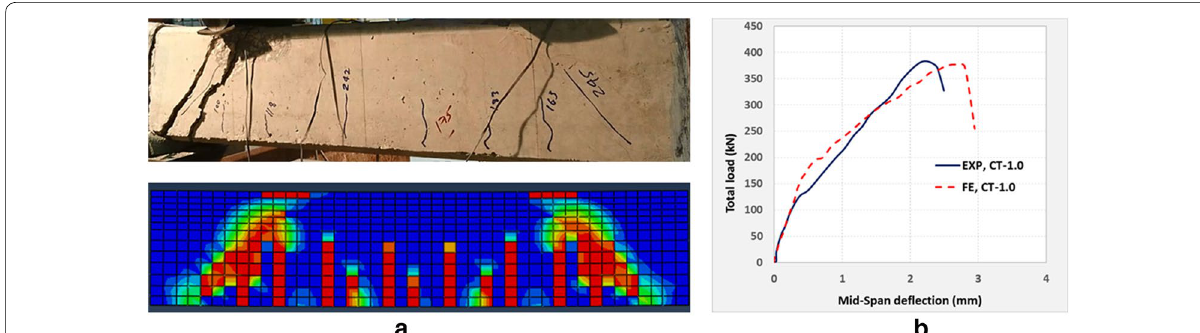
Fig. 17 Control beam (CT‑1.0): a failure mode of experimental and FE, b load–deflection response.